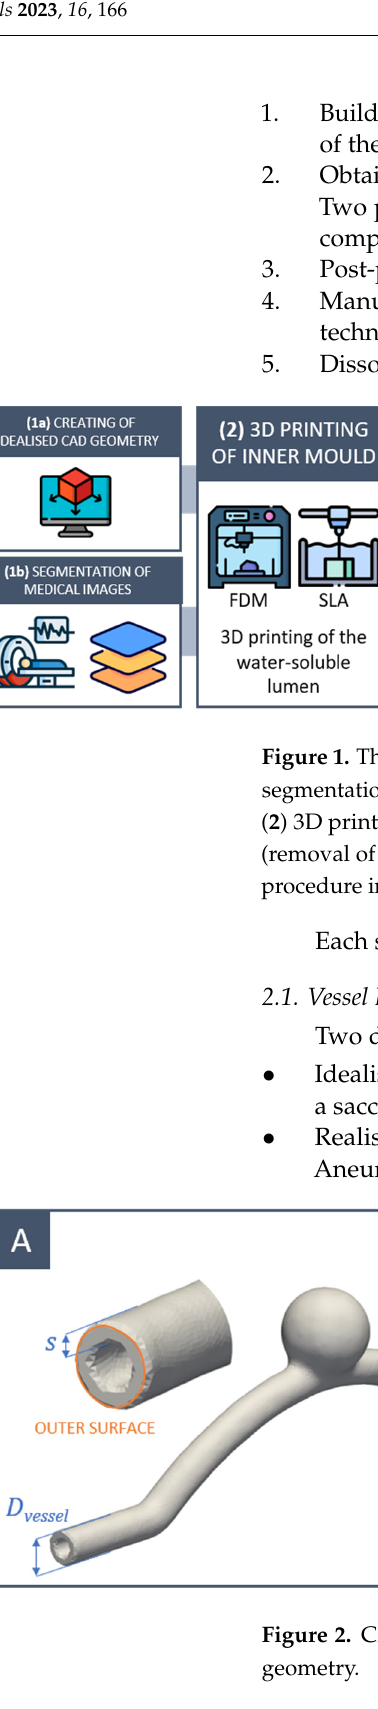
Figure 2. CAD geometry with offset for the inner mould of ( A ) idealised and ( B ) patient-specific geometry. The average diameter of the internal carotid is 4.66 mm for women and 5.11 mm for men [36]. Smaller and larger diameters were also considered in this work to assess the final spatial resolution of the proposed manufacturing process. Thus, idealised vessels